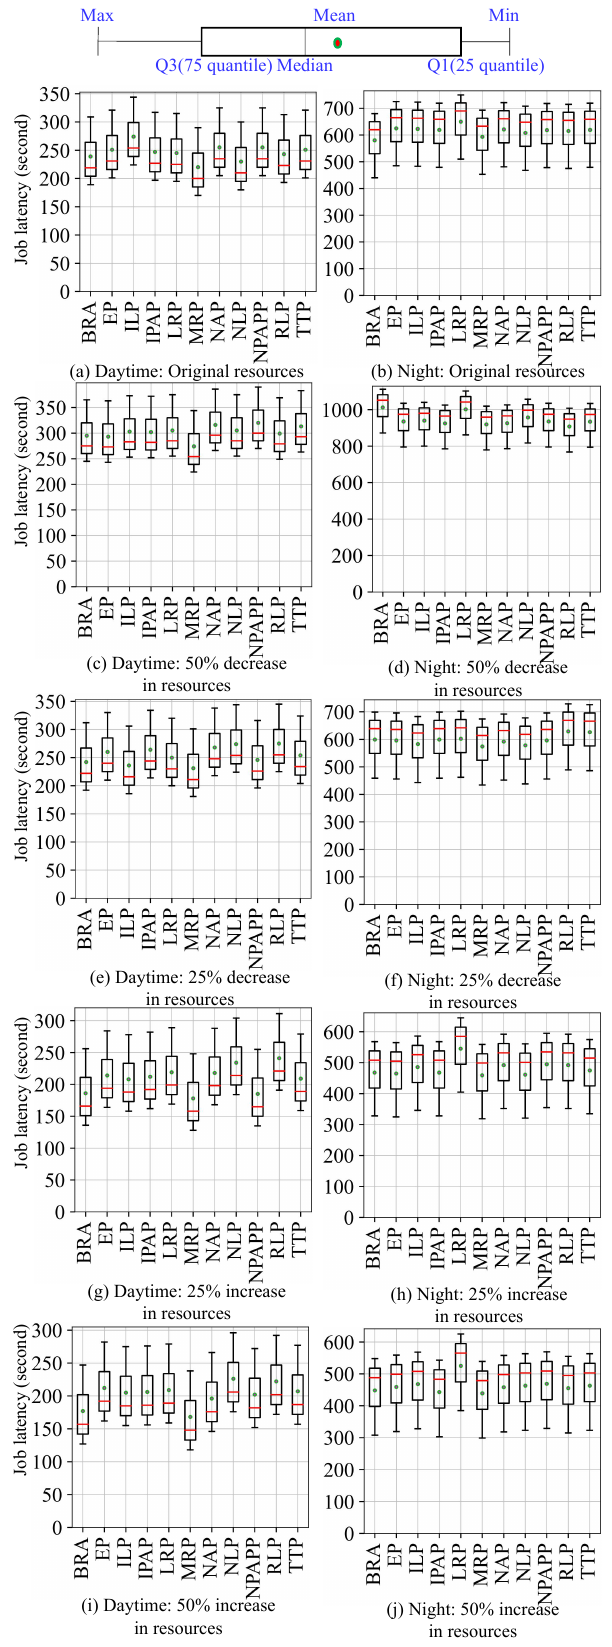
Figure 9. Real cluster: TaskQueue